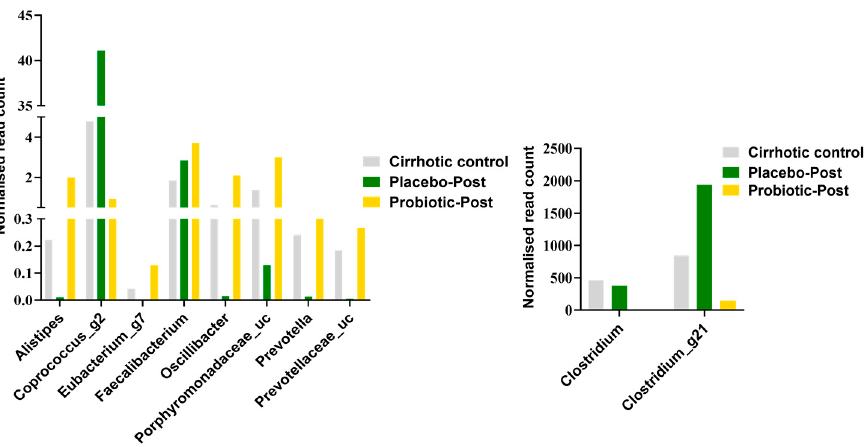
Figure 5. Microbial composition and LPS level measurement in placebo and probiotics groups at day 0 and at day 7. Comparative representation of selective genera between the groups, normalized by normal control group.